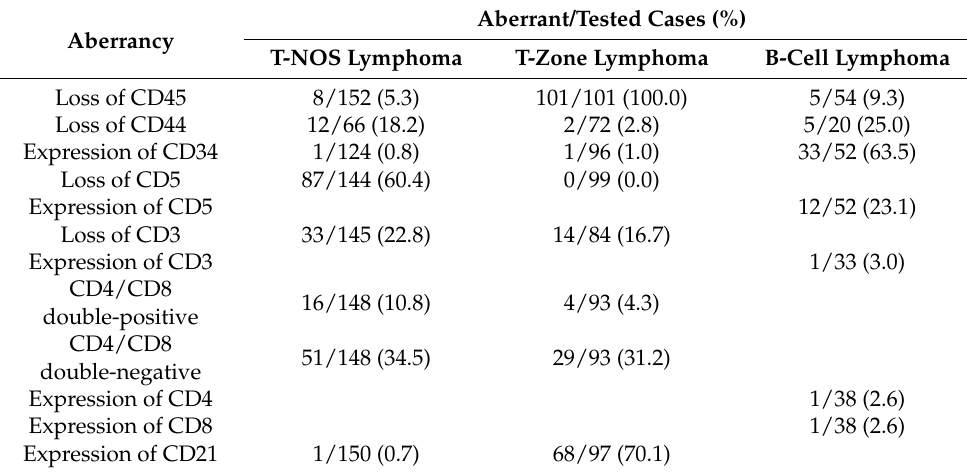
Table 2. Prevalence of specific antigen aberrancies among 310 dogs with lymphoma, according to the lymphoma